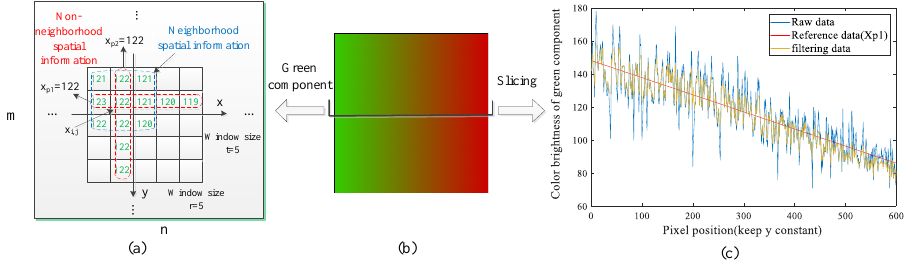
Figure 4. Non-neighborhood spatial information. ( a ) Spatial information, ( b ) Aliasing image, ( c ) Non-neighborhood spatial information in the direction of x.